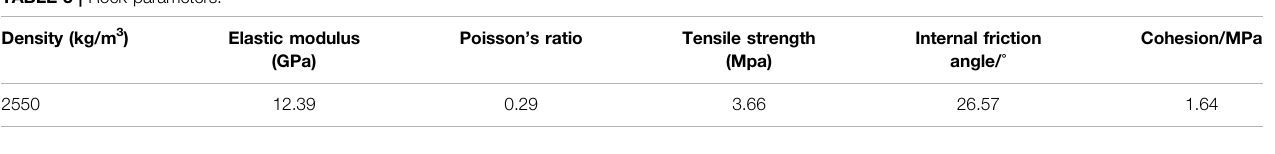
TABLE 3 | Rock parameters.